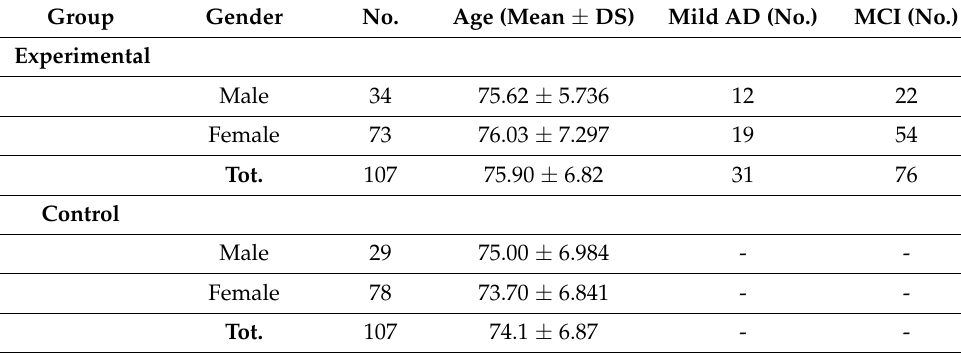
Table 1. Demographic and clinical characteristics of the sample. Group Gender No. Age (Mean ± DS) Mild AD (No.) MCI (No.) Experimental